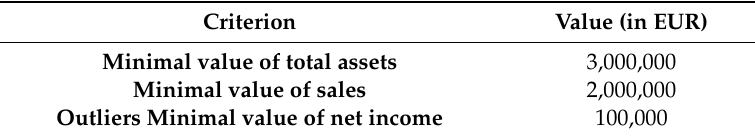
Table 1. Selection criteria of analyzed